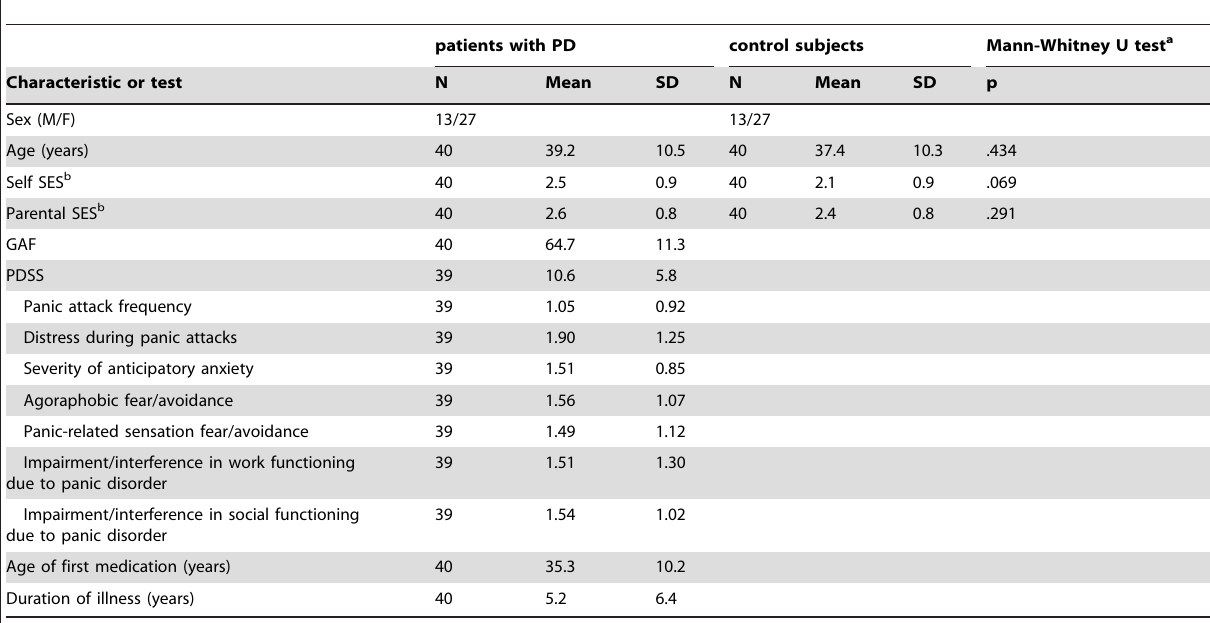
Table 1. Demographic and clinical characteristics of the